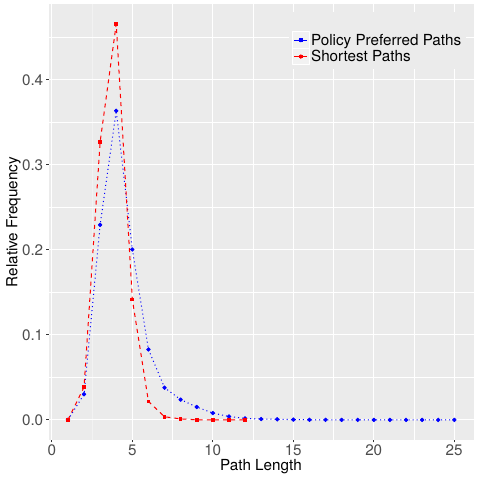
Figure 6: Relative path length frequencies for PPP and